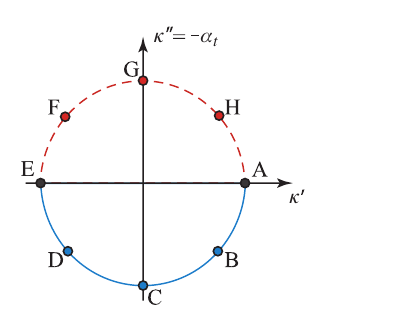
Figure A1: Characteristic of proper (lower half-plane) and improper (upper half-plane) waves in the complex κ ′ − κ ″ plane. Letters from A to H correspond to the appropriate cases depicted in Table